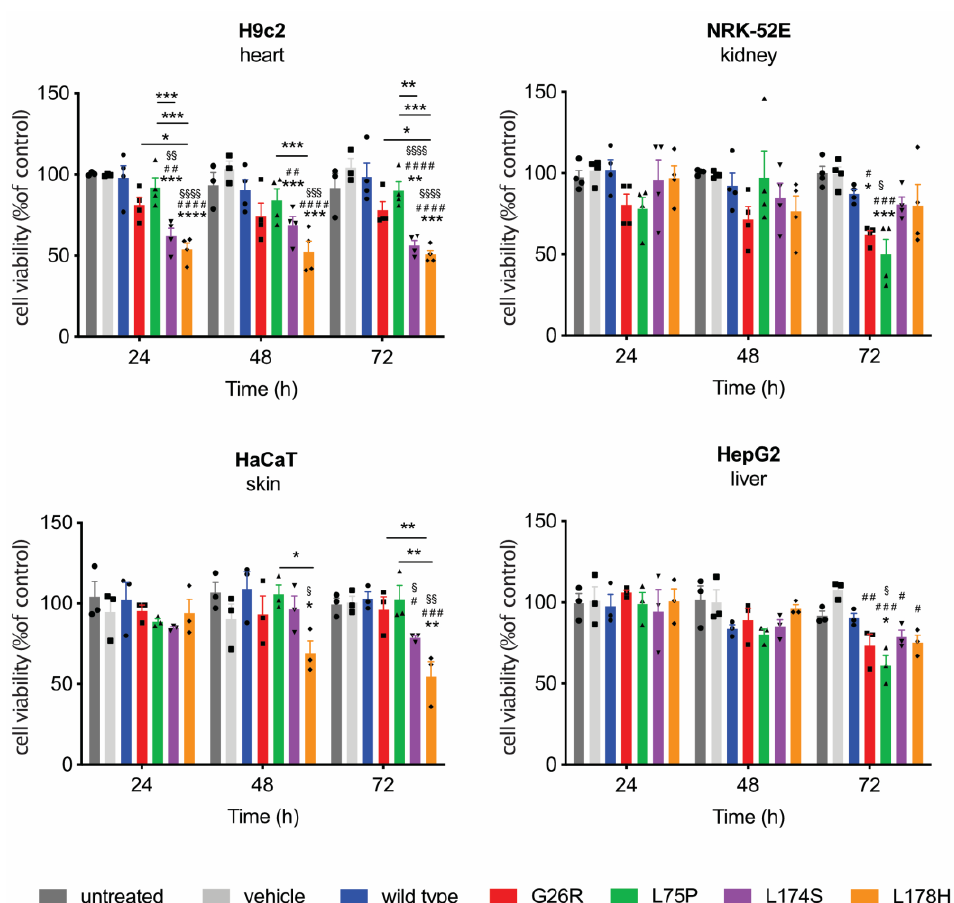
Figure 1. ApoA-I amyloidogenic variants affect cell viability in a cell-type specific way. H9c2, NRK-52E, HaCaT and HepG2 cells were incubated with 2 µ M of each ApoA-I amyloidogenic variant, as well as the WT protein, for the indicated length of time. At the end of incubation, cell viability was determined by performing a MTT (3-[4,5-dimethylthiazol-2-yl]-2,5-diphenyltetrazolium bromide) assay. Data shown are the means ± SEM of at least three independent experiments carried out in triplicate. Significance was calculated according to 2way ANOVA (* p < 0.05, ** p < 0.005, *** p < 0.001, **** p < 0.0001 refers to groups as indicated with respect to untreated cells, # p < 0.05, ## p < 0.005, ### p < 0.001, #### p < 0.0001 refers to groups as indicated with respect to vehicle treated cells, § p < 0.05, §§ p < 0.005, §§§ p <